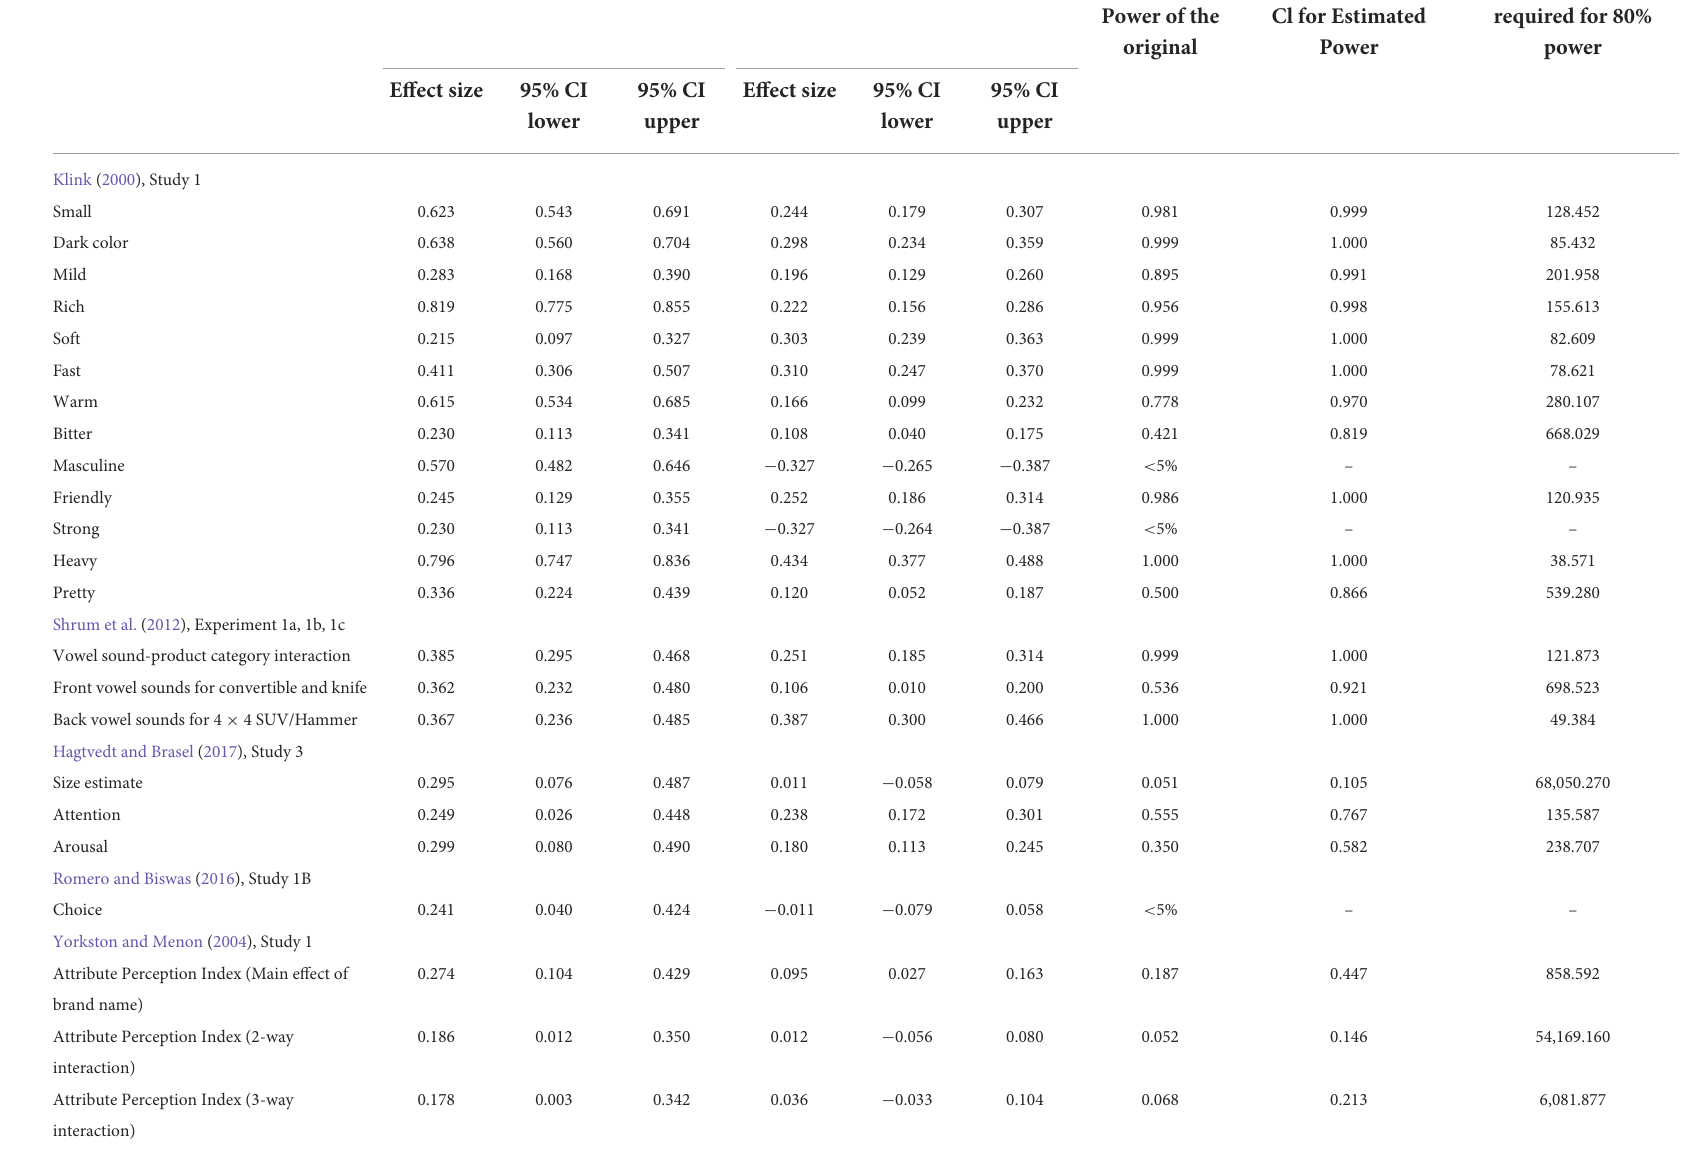
TABLE 5 Detailed findings of selected 10